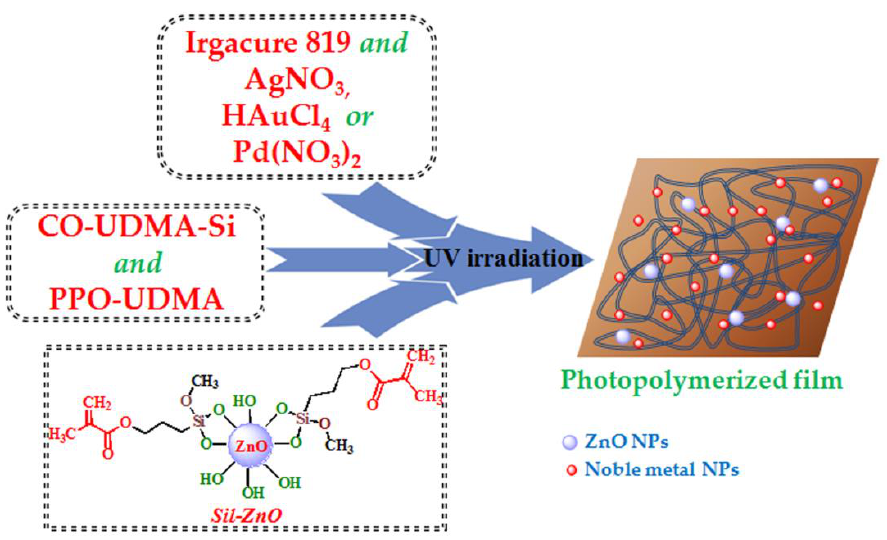
Figure 4. Schematic illustration of the concomitant photopolymerization of methacrylate monomers and in situ photoreduction of metallic salts under UV irradiation with the formation of hybrid polymer networks.